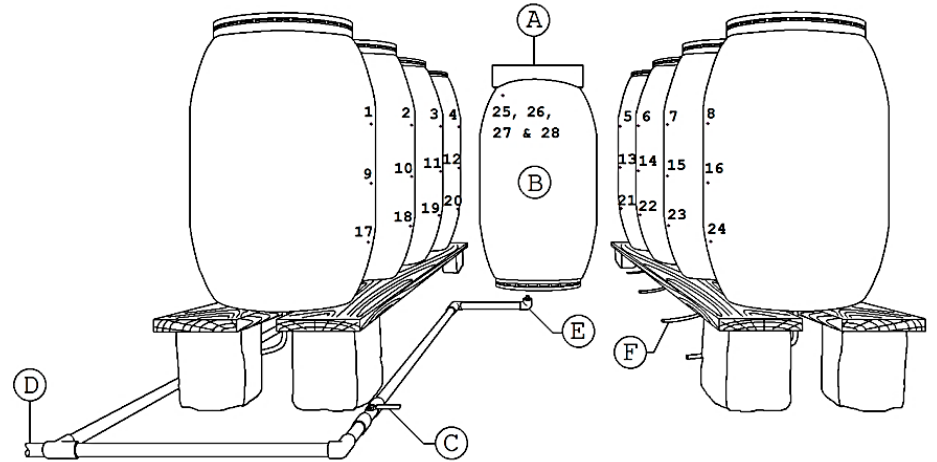
Figure 3. Configuration of a local-made water heating vessel. (a) Water heating vessel, (b) water inlet, (c) transparent hose, (d) forced air inlet, (e) air and water vapor mixture outlet, (f) electric heating element, (g) electric wires.